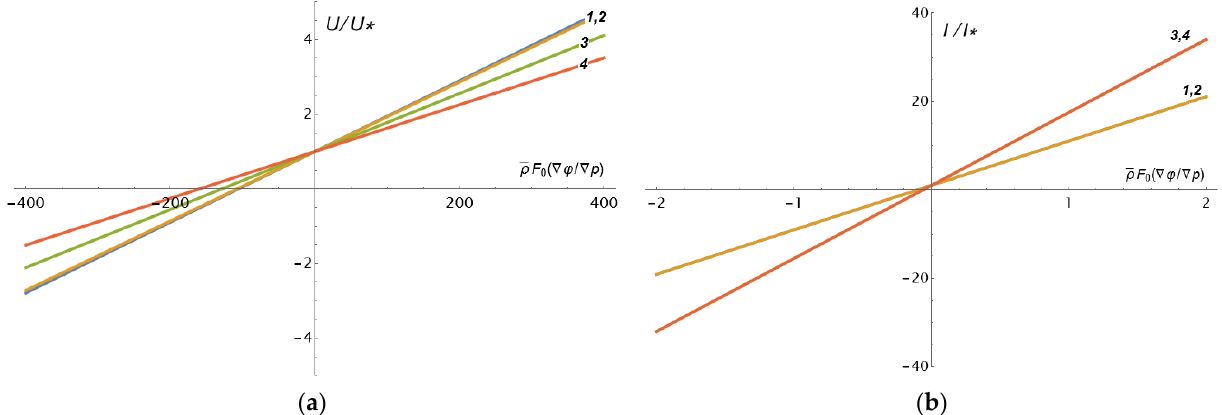
Figure 5. Dependences of ratios of HCl electrolyte filtration velocities U / U ∗ ( a ) and current density I / I ∗ ( b ) as functions of the dimensionless ratio of electric potential and pressure gradients ρ F 0 ∇ ϕ ∇ at concentration C 0 = 0.5M, calculated using formulas (9a) and (10a) respectively: p = m 0 = 9.6%, s 0 = 1 (1); m 0 = 9.6%, s 0 = 10 (2); m 0 = 30%, s 0 = 1 (3); m 0 = 30%, s 0 = 10